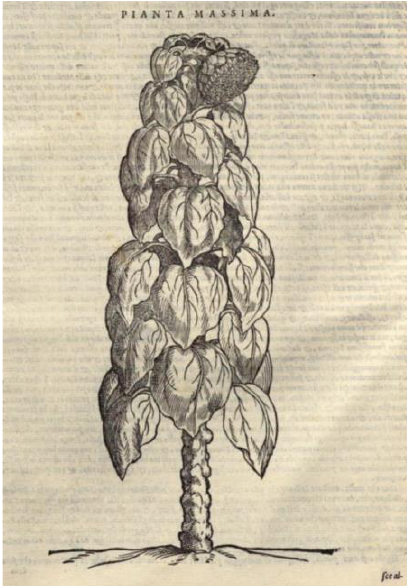
Figure 1. Drawing of a sunflower plant as reported in a letter from Cortuso to Mattioli (1585). https://archive.org/details/bub_gb_H-bmaXwpdr8C/page/n31/mode/1up. (Accessed on 5 August 2022).